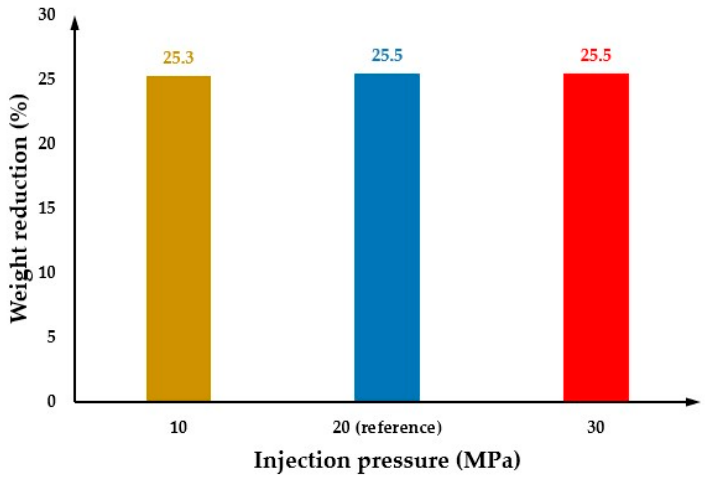
Figure 18. The weight reduction as a function of injection pressure.